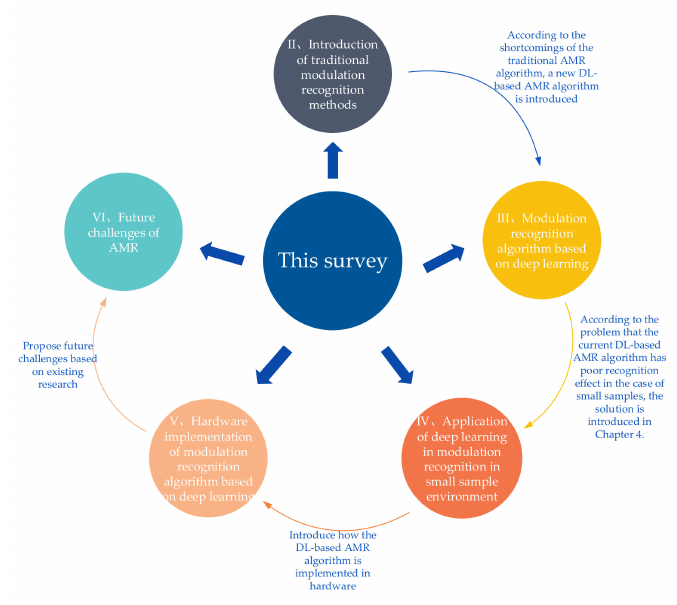
Figure 1. The structural layout of this paper.